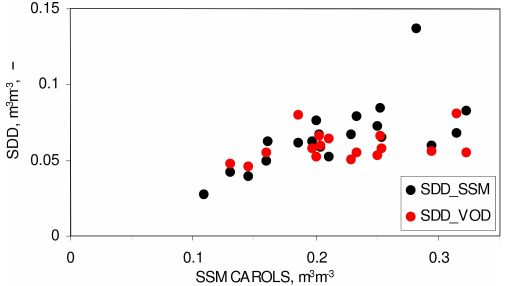
Fig. 12. Impact of SSM conditions (as observed by CAROLS) on the spatial standard deviation of differences (SDD) between the CAROLS SSM and VOD and the simulated values (Table 2, only for p-value <